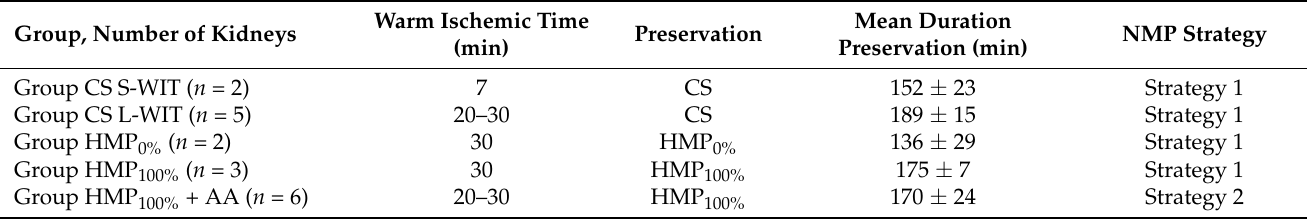
Table 1. Specification of all kidneys perfused during the development of the slaughterhouse model.